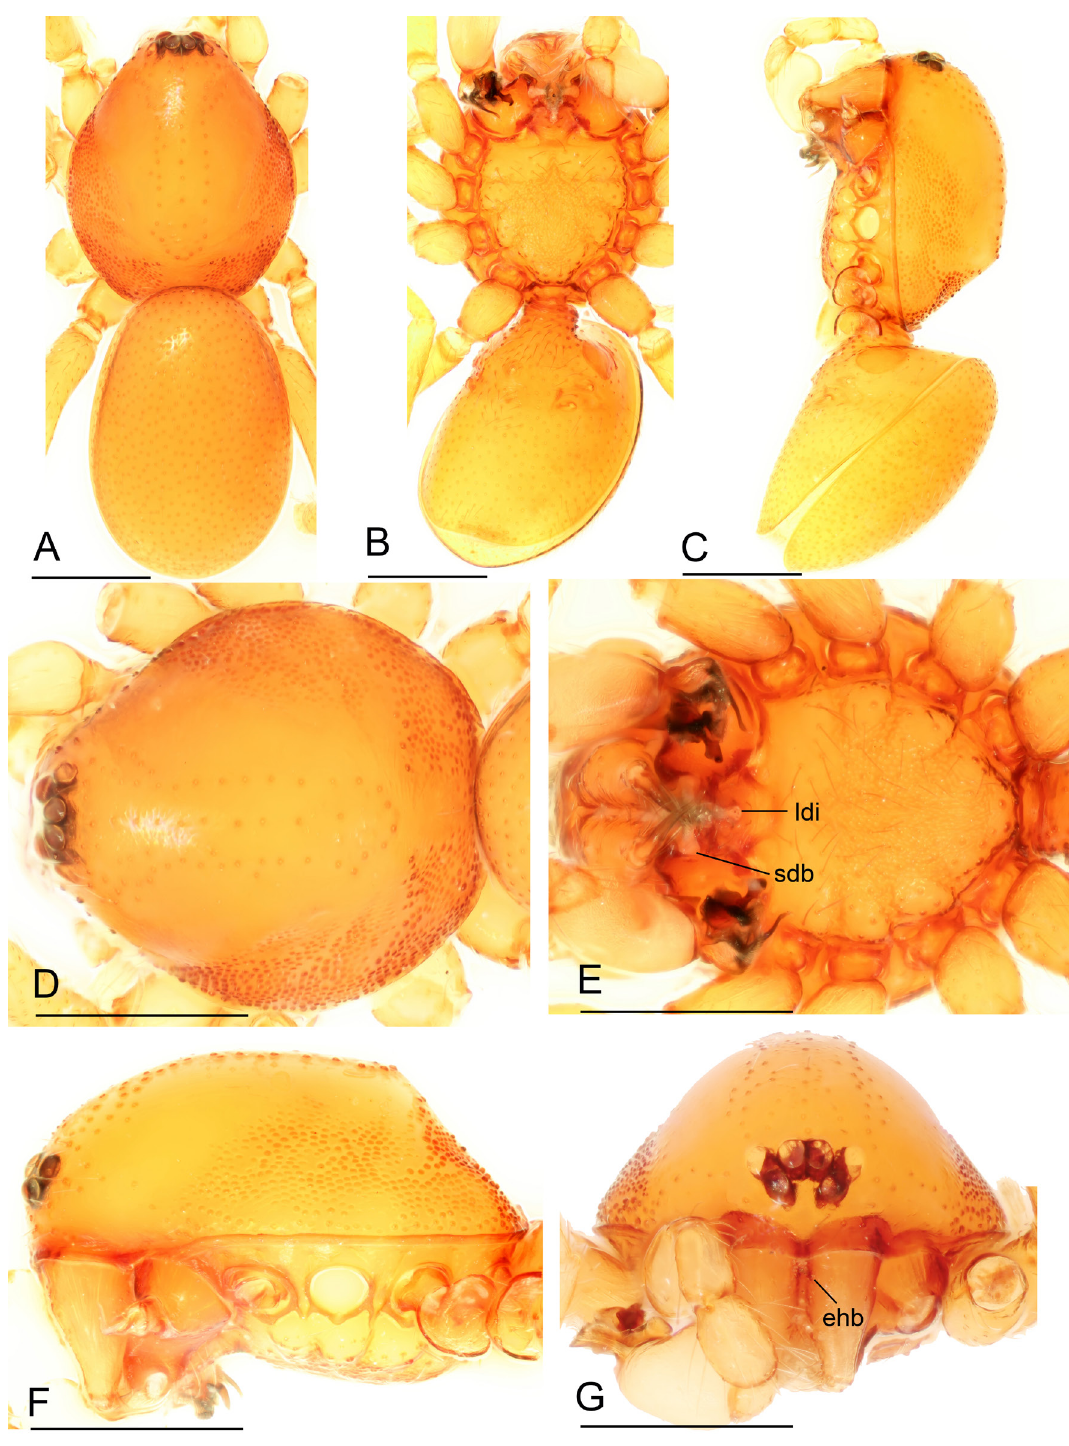
Fig. 5. Trilacuna jiuchi Tong, Zhang & Li sp. nov., holotype, ♂ (SYNU-300). A – C . Habitus in dorsal, ventral, and lateral views. D – G . Prosoma in dorsal, ventral, lateral, and anterior views. Abbreviations: ehb = elevated hair base; ldi = labium deep incision; sdb = strongly curved distal branch. Scale bars: 0.4